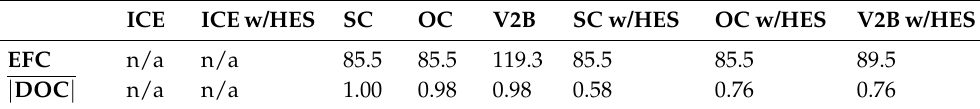
Table 4. Annual amount of equivalent full cycles (EFC) and the absolute depth of cycle (DOC) (normalized to the amount of EFC) of the battery taken as an average from the commuter and supplementary electric vehicle